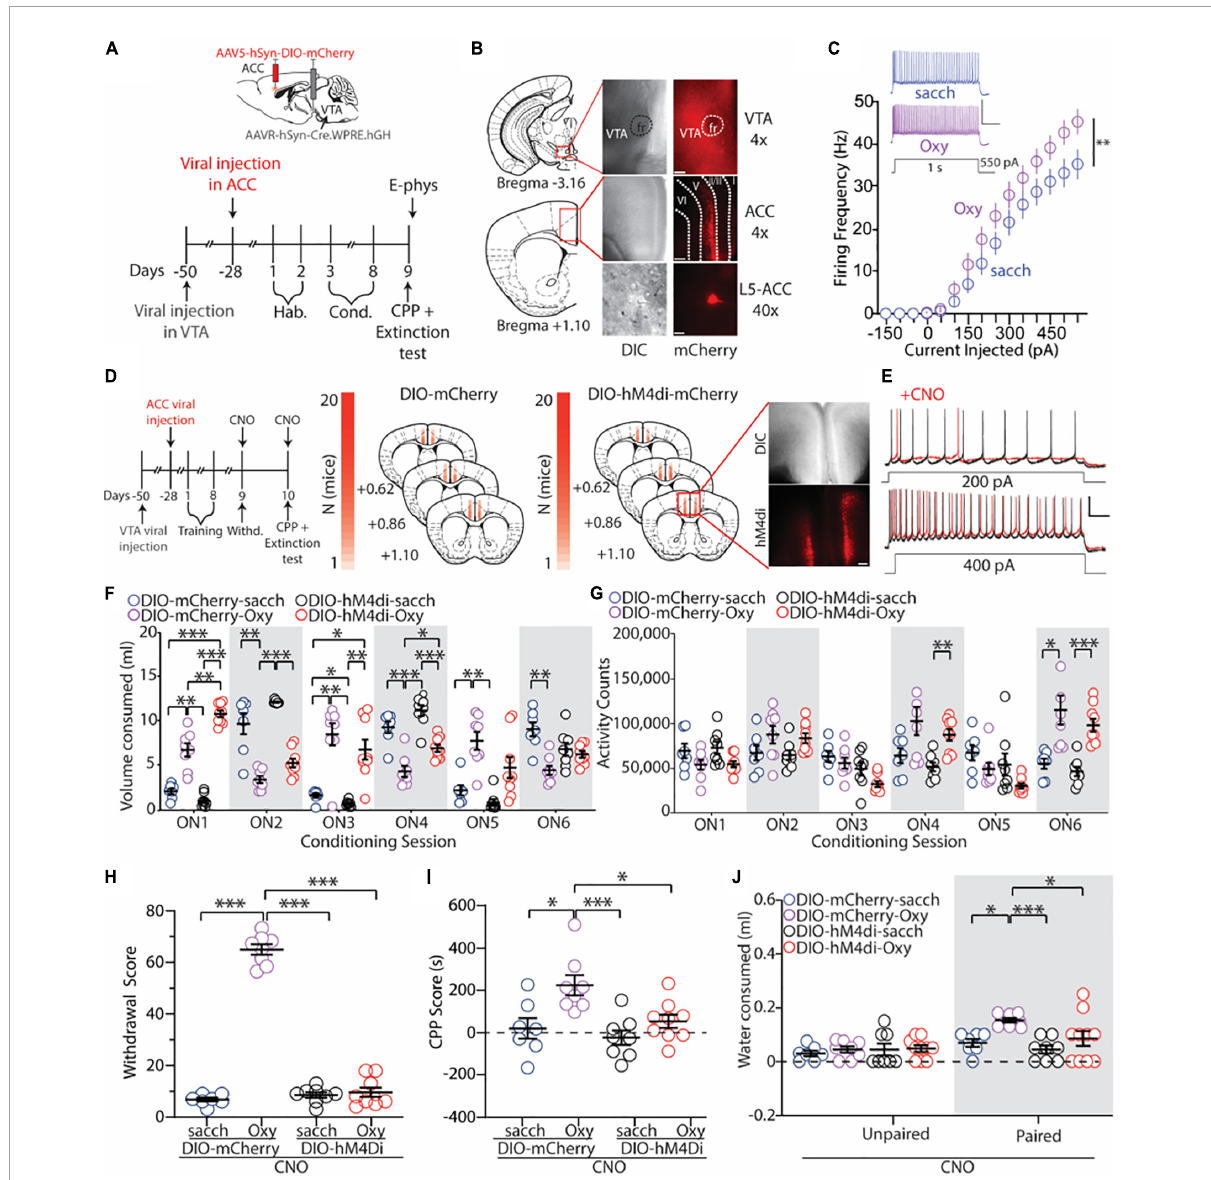
FIGURE4 Inhibition of ACC neurons that project to the VTA blocks the expression of oxycodone withdrawal, place preference, and drug-seeking behaviors. (A) Experimental timeline showing that electrophysiology assessments were performed immediately after the 1 h extinction test in control or oxycodone (0.5 mg/ml) self-administering mice injected with DIO-mCherry bilaterally in the ACC. (B) 4 × images of viral expression in the VTA (top) and ACC (middle). (Bottom) 40 × image of a fluorescently-labeled VTA-projecting neuron in layer 5 of the ACC. Dashed lines indicate cortical layers I, II/III, V, and VI. Scale bars = 200 µ m (4 × ) and 20 µ m (40 × ). (C) Summary graph showing that following the 1 h extinction test, the number of action potentials fired in VTA-projecting ACC neurons is significantly increased in mice who orally self-administer oxycodone vs. vehicle controls. Scale bars: 50 mV, 200 ms [ F ( 14 , 336 ) = 2.551, p = 0.0017, two-way repeated-measures ANOVA with Bonferroni post hoc test] (DIO-mCherry-sacch: n = 12/4; DIO-mCherry-Oxy: n = 14/4; cells/mice). Scale bars = 50 mV, 0.2 s. (D) Experimental timeline and placements of viral injections in mice injected with DIO-mCherry or DIO-hM4di. Scale bars = 200 µ m. (E) Representative traces showing bath application of CNO (3 µ M) decreases the excitability of transduced VTA-projecting ACC neurons. Scale bars = 25 mV, 100 ms. (F) Summary graph showing the volume of solution consumed between groups during overnight conditioning sessions (ON1-6) [ F ( 15 , 140 ) = 36.52, p < 0.0001, two-way repeated-measures ANOVA with Bonferroni post hoc test] (DIO-mCherry-sacch: n = 7; DIO-mCherry-Oxy: n = 8; DIO-hM4di-sacch: n = 8; DIO-hM4di-Oxy: n = 9]. (G) Summary graph showing the locomotor activity counts across conditioning sessions [ F ( 15 , 140 ) = 10.36, p < 0.0001, two-way repeated-measures ANOVA with Bonferroni post hoc test] (DIO-mCherry-sacch: n = 7; DIO-mCherry-Oxy: n = 8; DIO-hM4di-sacch: n = 8; DIO-hM4di-Oxy: n = 9). (H) Summary graph showing the withdrawal score of control and oxycodone-conditioned mice expressing mCherry or hM4di in ACC neurons that project to the VTA. Experiments were performed in the presence of CNO (2 mg/kg, i.p.) [ F ( 3 , 28 ) = 327.4, p < 0.0001, one-way ANOVA with Bonferroni post hoc test] (DIO-mCherry-sacch: n = 7; DIO-mCherry-Oxy: n = 8; DIO-hM4di-sacch: n = 8; DIO-hM4di-Oxy: n = 9). (I) Summary graph showing that inhibition of VTA-projecting